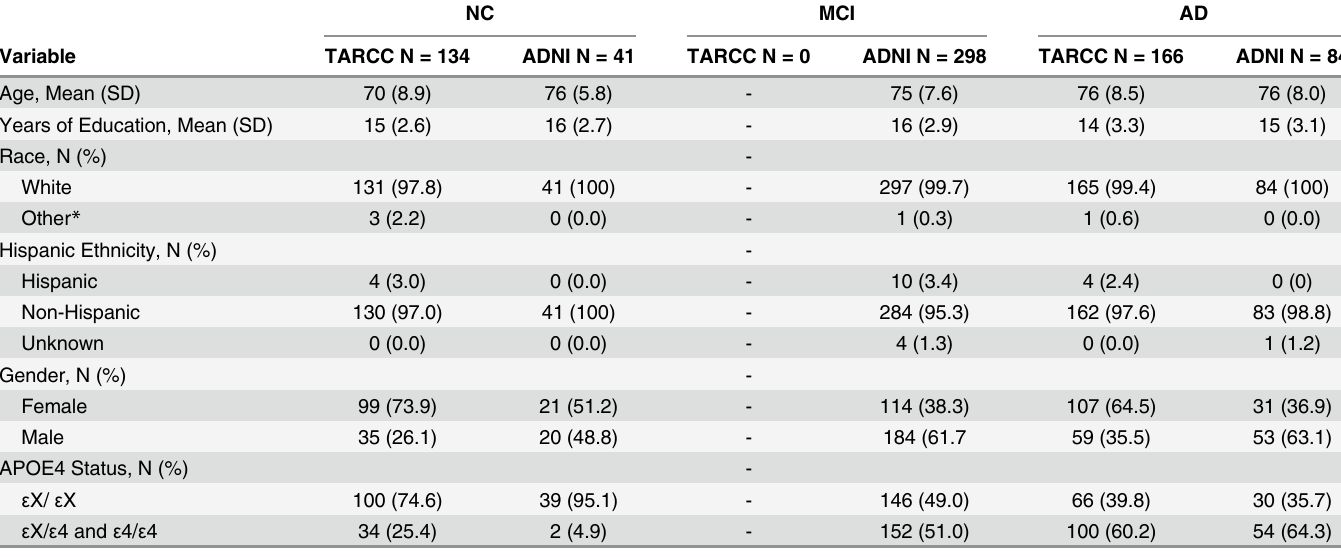
Table 1. Demographic characteristics of the Texas Alzheimer ’ s Research and Care Consortium (TARCC) and the Alzheimer ’ s Disease Neuroimag- ing Initiative (ADNI) cohorts. NC